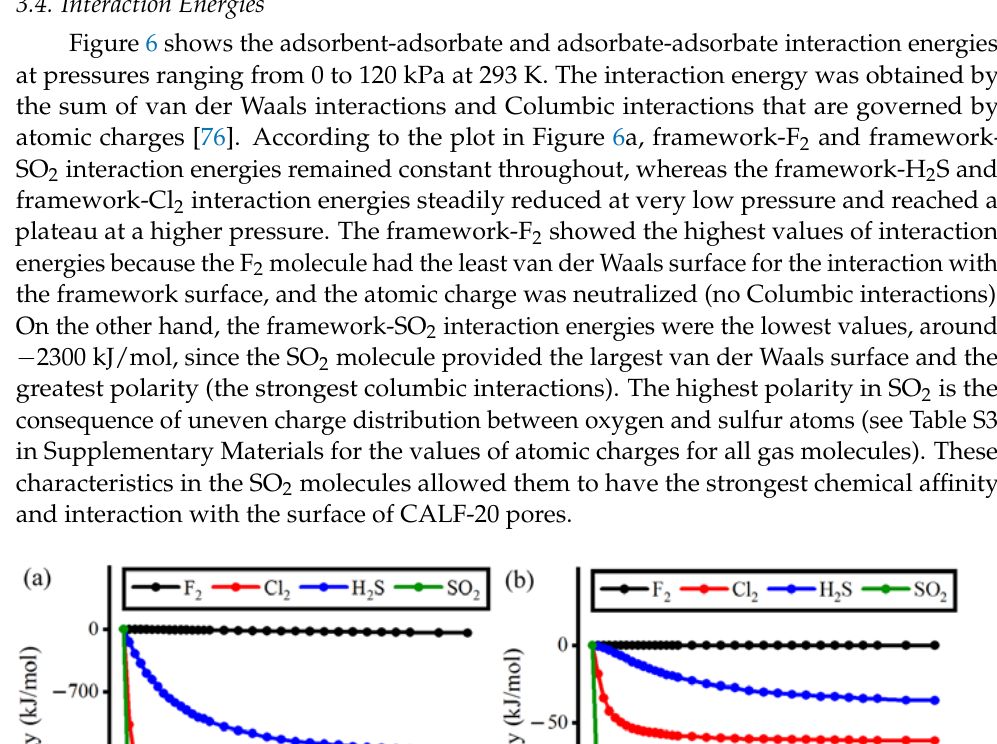
Figure 5. ( a ) Simulation snapshots of F 2 , Cl 2 , H 2 S, and SO 2 adsorption in CALF-20 framework at 10, 50, and 100 kPa as visualized along the Y-axis, ( b ) magnified SO 2 packing in CALF-20 pores, presented along X-axis of the framework.